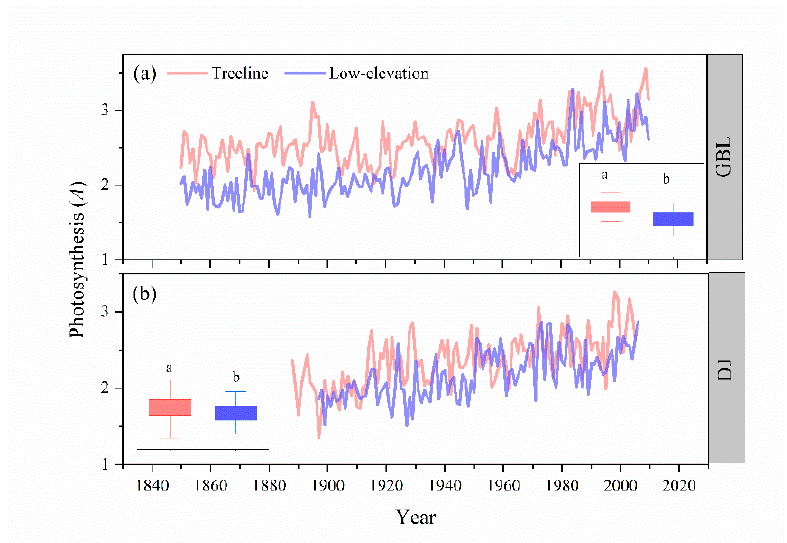
Figure 6. The temporal changes in photosynthesis ( A ) for each forest stand of the two elevational transects GBL ( a ) and DJ ( b ). The photosynthesis rates are derived from a transformation of Equation (4): A = iWUE · g s = iWUE · δ 18 O . Different letters demonstrate significant differences ( p < 0.05) between treelines and low-elevation forests based on two-tailed two-sample t -tests, assuming equal